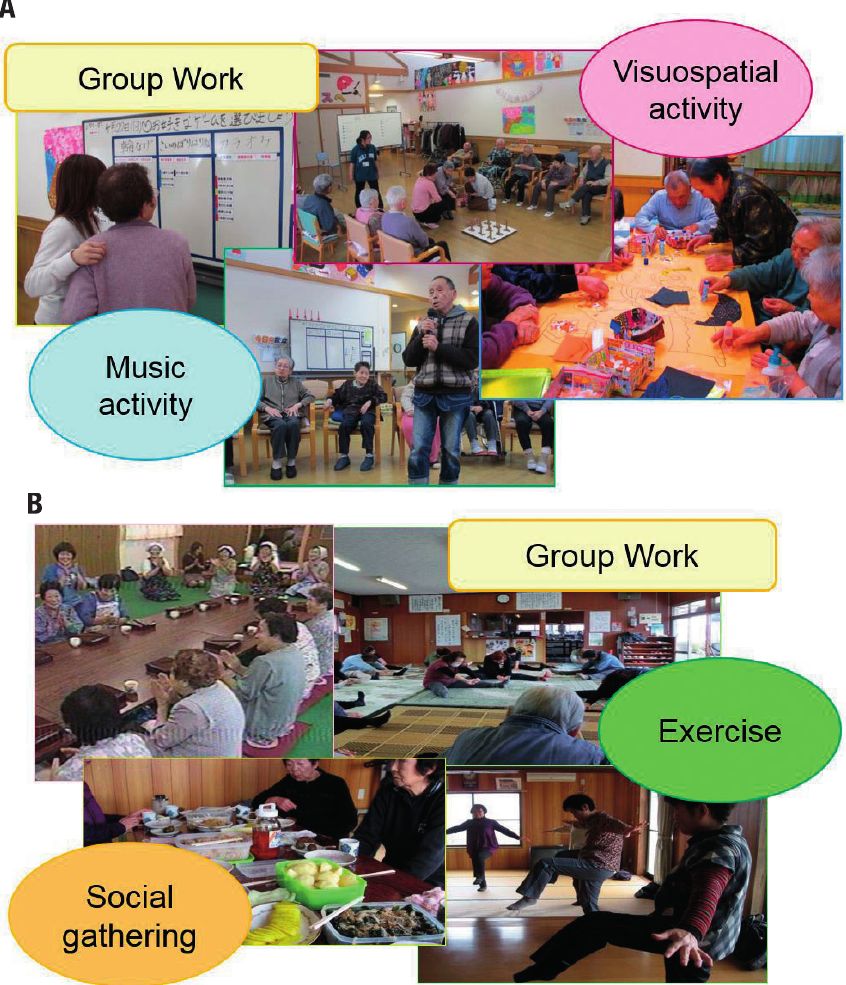
Figure 1. [A] music visuospatial activities [B] social gathering and